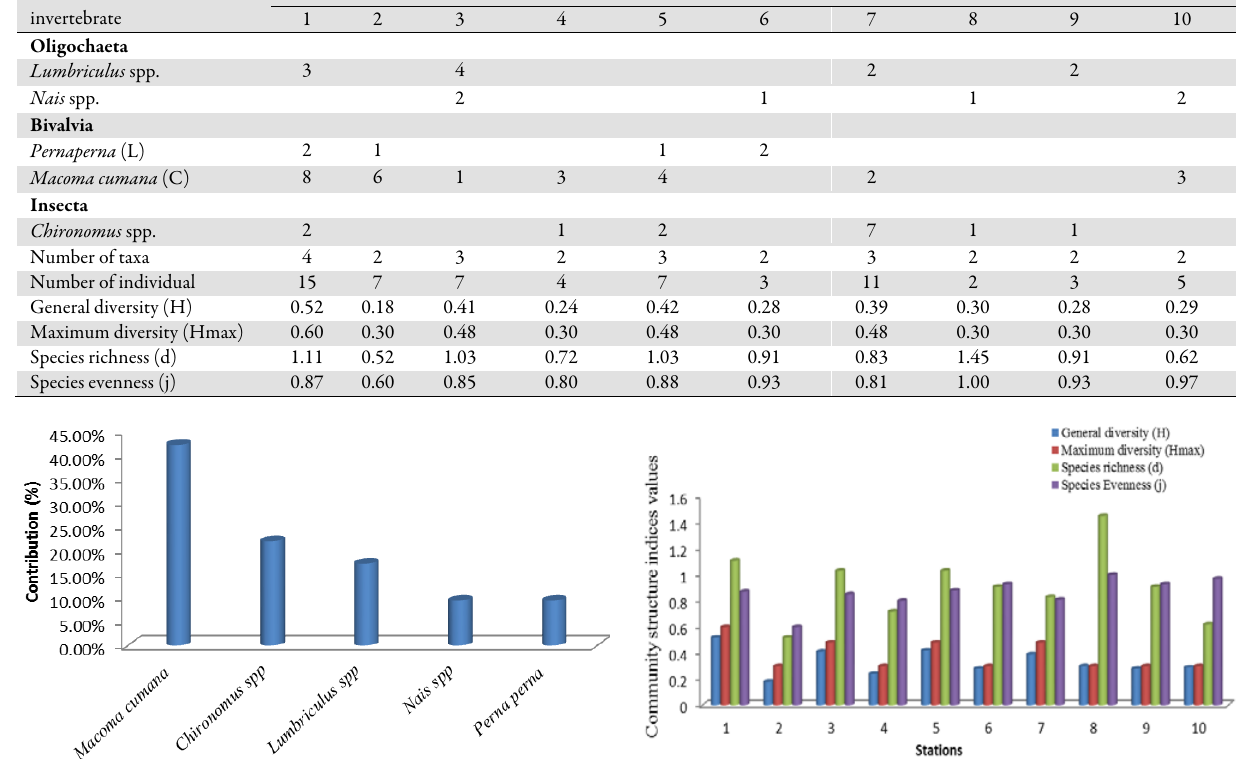
Fig. 6. Comparison of macrobenthic invertebrates community structure indices at Ibefun River, Ogun